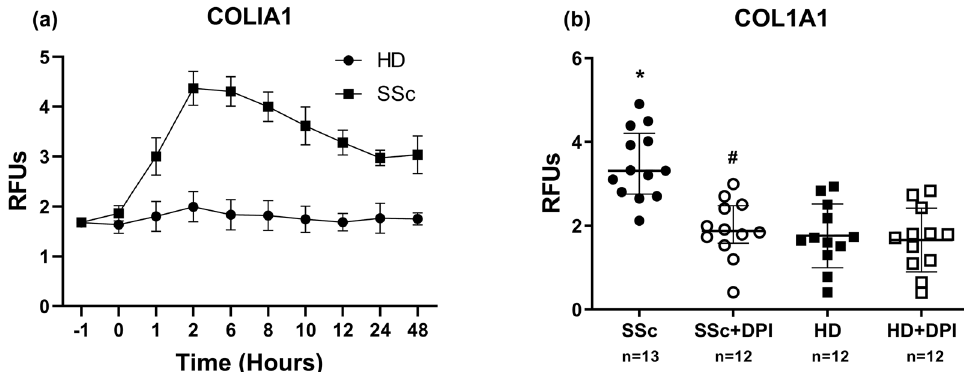
Figure 3: E ff ects of SSc sera on HPMECs collagen ( COL1A1 ) promoter activation. ( a ) SSc sera induce HPMECs collagen synthesis. Subcon fl uent HPMECs were transduced with lentiviral particles obtained from the COL1A1 - LV - tGFP and EF1 α - LV - FP602 lentivectors, and then cultured in basal medium containing 10% ( v/v ) of sera from SSc patients ( SSc ) and healthy donor ( HD ) . Variations of COL1A1 promoter activation were kinetically followed for 48 h ( a randomly selected representative experiment is reported ) and values at 8 h were used for comparison in B. ( b ) SSc sera - induced COLIA1 increase in HPMECs is mediated by NADPH oxidases. Before sera stimulation, subcon fl uent HPMECs were transduced with lentiviral particles obtained from the COL1A1 - LV - tGFP and EF1 α - LV - FP602 lentivectors and then cultured for 48 h in basal medium containing 10% ( v/v ) of sera from SSc patients and HD; then values at 2 h were used for comparisons. In selected experiments, viral - transduced HPMECs were preincubated for 1 h with 5 µM of the NADPH oxidase inhibitor DPI before sera stimulation. ( a ) and b ) Data are expressed as normalized transduction e ffi ciency by reporting the mean ± SD of the RFUs ratio of COL1A1 - LV - tGFP to EF1 α - LV - FP602. ( b ) Horizontal lines indicate the mean value and standard deviation range. Kruskall – Wallis one - way analysis of variance, followed by a post hoc Dunn ’ s test for multiple comparisons, was used to detect di ff erences among studied groups. * p ≤ 0.0005, signi fi cantly di ff erent from the control group ( HD ) ; # p ≤ 0.005, signi fi cantly di ff erent from the SSc group ( SSc )